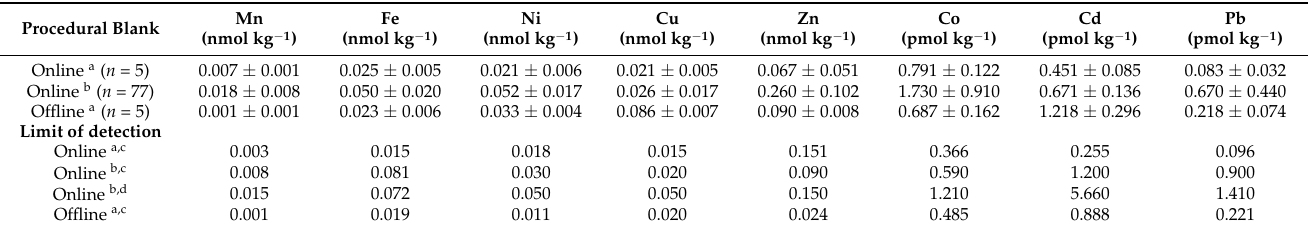
Table 4. Procedural blanks and Limit of Detection values for online and offline methods.